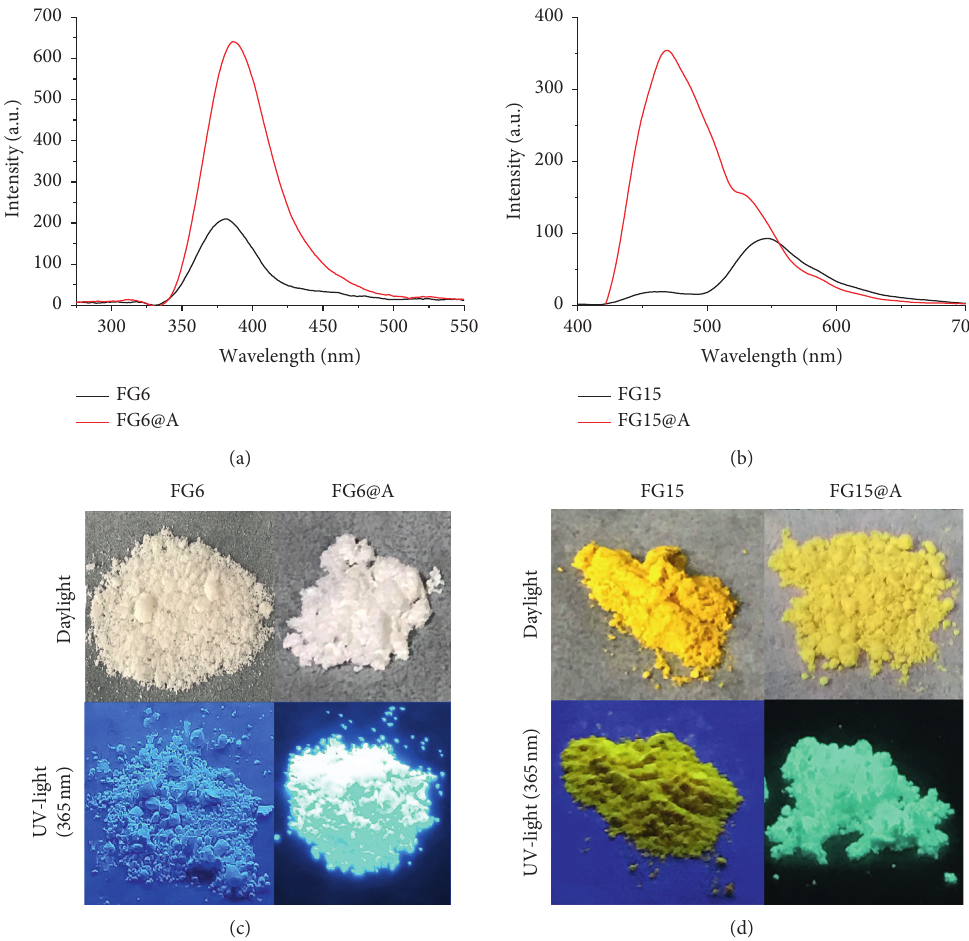
Figure 3: Comparison of fluorescence spectra of (a) FG 6 and solid FG 6@ A ; (b) FG 15 and solid FG 15@ A ; the colour of (c) FG 6 and solid FG 6@ A ; (d) FG 15 and solid FG 15@ A under daylight and UV light (365